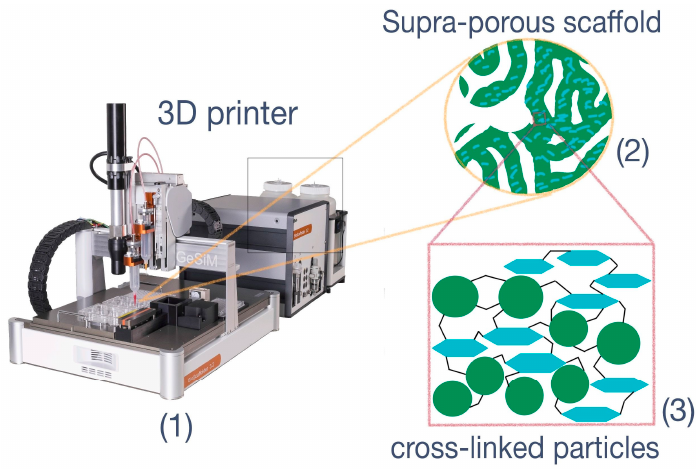
Figure 1. The idea of particle-based scaffold formation with application of DIW + SLA 3D-printing technologies. ( 1 ) 3D-printer supplied with extruder-type printing head and UV-lamp; ( 2 ) super- macroporous matrix with interconnected pores, which could serve as scaffold; ( 3 ) covalently cross- linked particles. The green circles represent PLA particles, and the turquoise hexagons indicate NCC particles.